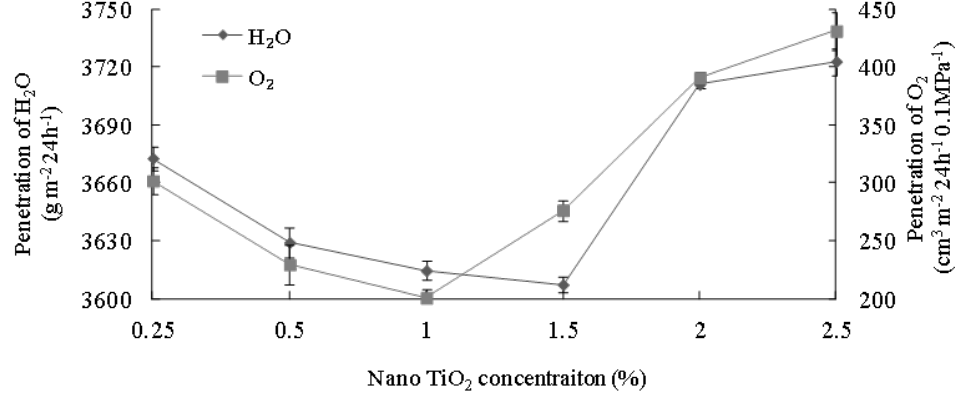
Figure 7. Effects of Nano-TiO 2 concentration on water vapor transmission and O 2 permeation.